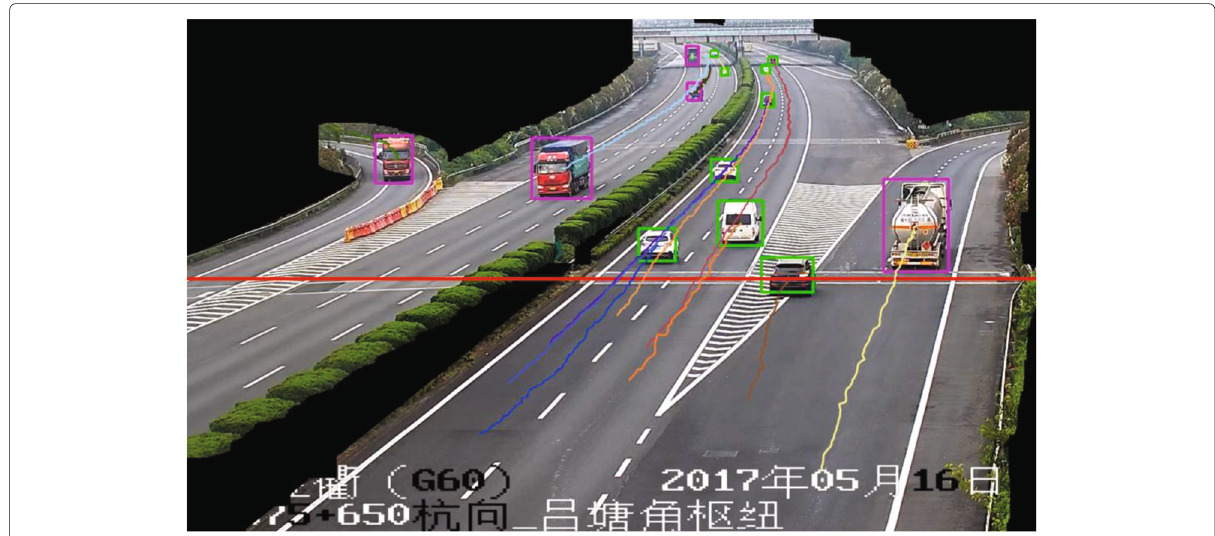
Fig. 12 Trajectory of the vehicle and detection